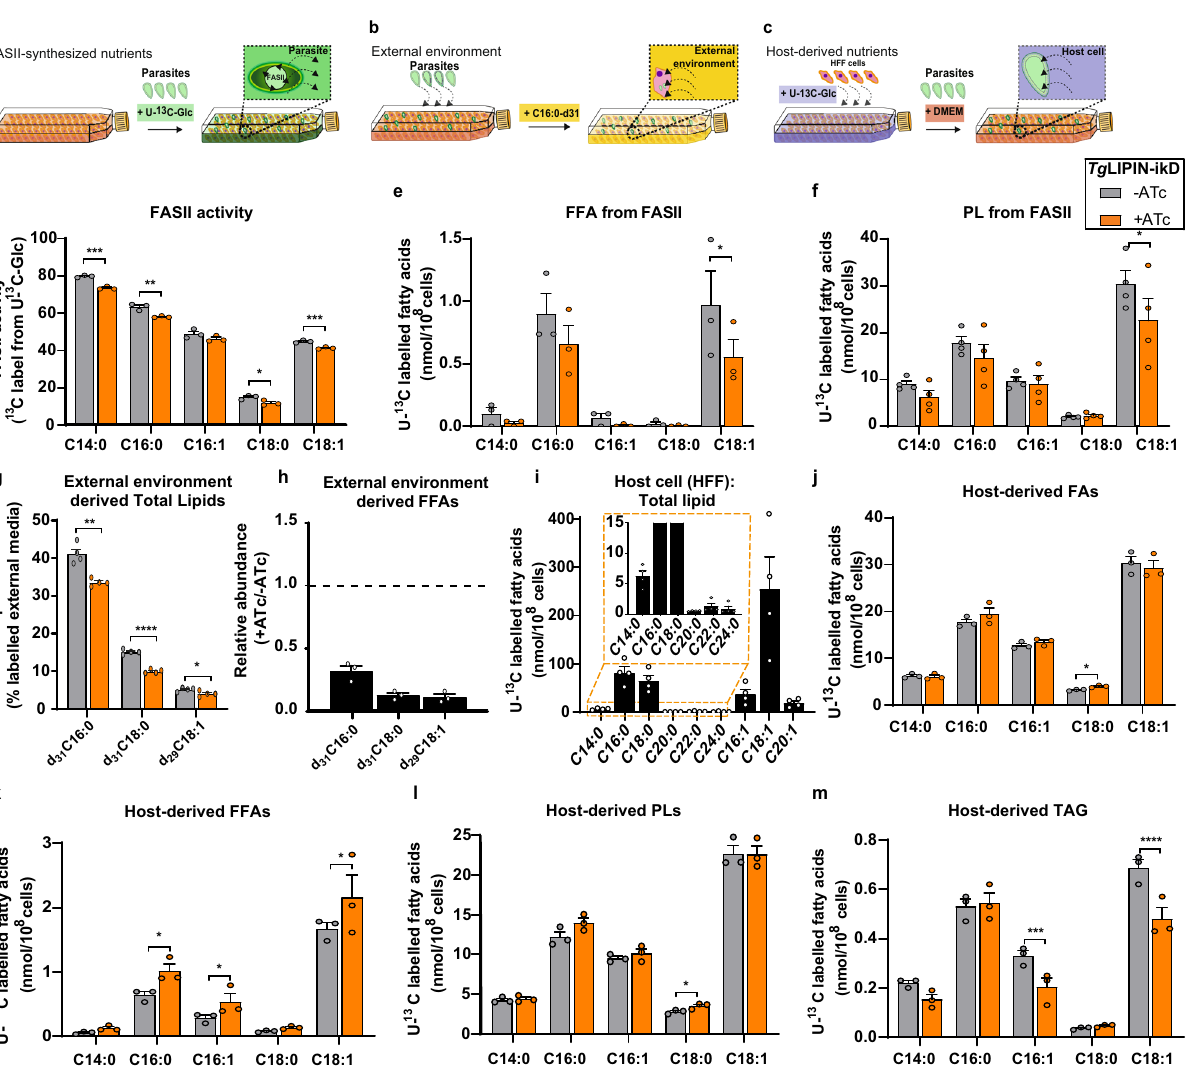
Fig. 5 Monitoring the source of fatty acids in Tg LIPIN-ikD. a – c Schematic for the experimental procedure of stable isotope labeling to determine the origin of fatty acids in Tg LIPIN-ikD; a Parasite FASII derived FAs were determined by the addition of U- 13 C-glucose (Glc) to the culture medium (1% FBS, no glucose, + / − ATc) at the time of parasite infection to the host. b FAs scavenged from the external environment (medium) was determined by the addition of 31 d-palmitic acid ( 31 d-C16:0) to the parasite culture medium (high glucose, 1% FBS). c Host cell-derived FAs were determined by growing host cells in the presence of U- 13 C-glucose (no glucose, 10% FBS) to con fl uent in prior to the infection parasites with normal medium (glucose, 1% FBS, + / − ATc). d FASII activity in Tg LIPIN-ikD as measured as % 13 C-incorporation ( n = 3, unpaired t test P values; *** P < 0.0005% FASII derived C14:0/C16:0/C18:0/ C18:1 − ATc vs + ATc, ** P < 0.007/* P < 0.04/*** P < 0.0003). e Abundance of apicoplast FASII derived 13 C labeled FFAs ( n = 3, unpaired t test P values; * P < 0.02 of FASII derived FFA C18:1-ATc vs + ATc). f Abundance of apicoplast FASII derived 13 C-labeled phospholipids (PLs, n = 4, unpaired t test P values; * P < 0.03 of FASII derived PL C18:0-ATc vs + ATc). g FA uptake of deuterated external environment-derived FAs ( n = 4, unpaired t test P values; ** P = 0.0034/*** P < 0.00001/* P = 0.01 FA uptake from the external environment as d 31 C16:0/d 31 C18:0/d 29 C18:1 − ATc vs + ATc). h Relative abundance of deuterated external environment-derived ( + ATc/ − ATc) ( n = 3). i The abundance of 13 C-labeled fatty acids in the host cells ( n = 4). j Host derived FAs measured as % 13 C-incorporation ( n = 3, unpaired t test P values; * P < 0.02 Host derived FA C18:1-ATc vs + ATc). k Abundance of host-derived 13 C-labeled FFAs ( n = 3, unpaired t test P values; * P < 0.05 Host derived FA C16:0/16:1/18:1 − ATc vs + ATc). l Abundance of host-derived 13 C labeled PL ( n = 3, unpaired t test P values; * P < 0.023 Host derived PL C18:0 − ATc vs + ATc) and m TAG levels ( n = 3, unpaired t test P values; *** P < 0.0001 Host-derived TAG C16:0/18:1 − ATc vs + ATc). Data are all presented as mean values + / −